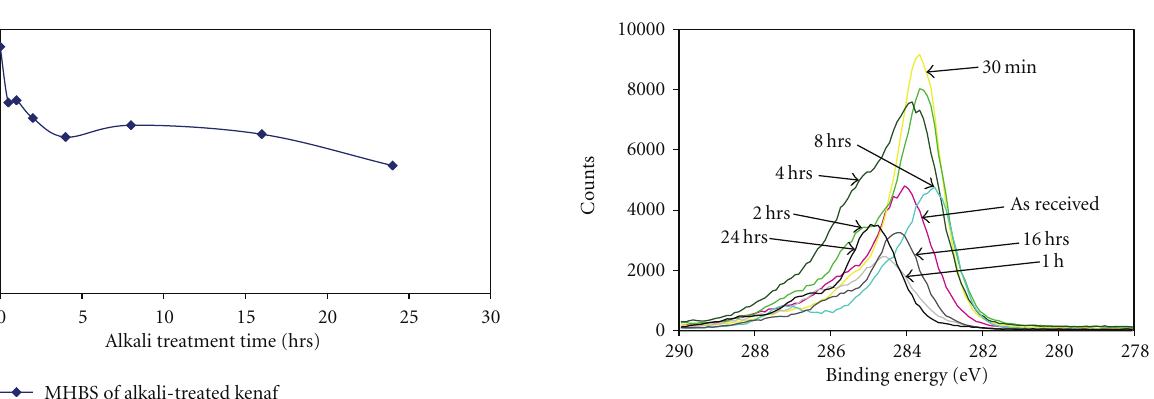
Figure 7: E ff ect of time on MHBS of alkali-treated kenaf fibers.